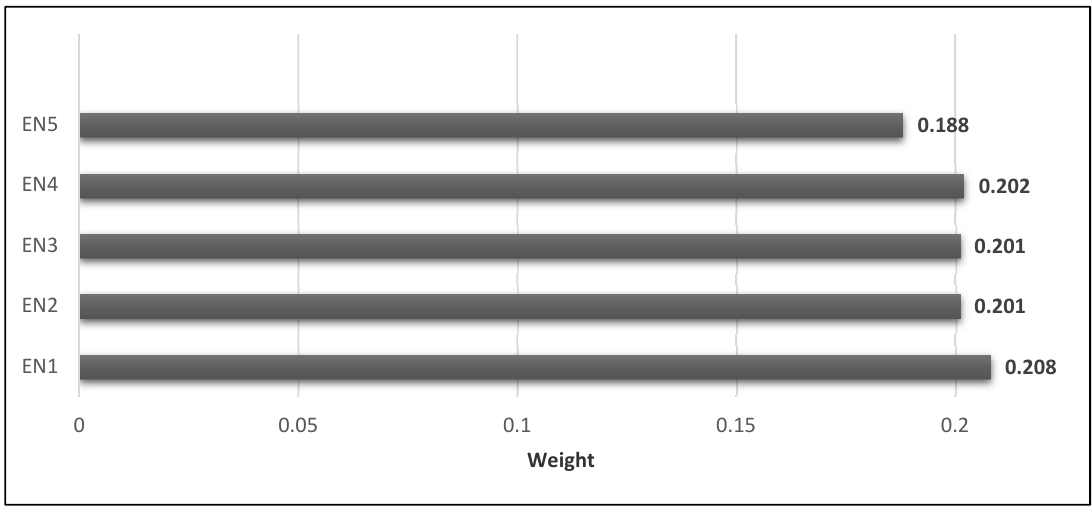
Figure 5. Ranking of green innovation sub-criteria with respect to the environmental (EN) criteria.